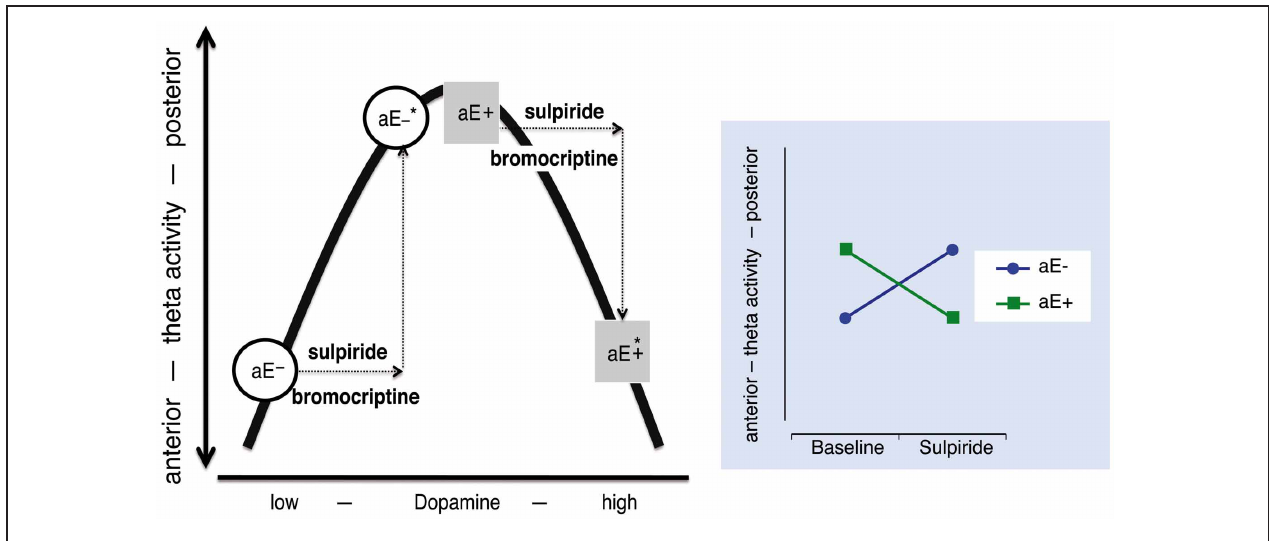
aE − are shifted to positions ( ∗ ) that mark opposing changes (disordinal interaction, see Substance × aE plot on the right side): aE − are shifted to medium and aE + to high dopamine levels, resulting in more or less posterior vs. anterior theta activity, respectively. Such inverse U-shaped functions can be seen as the result of two underlying processes, but without such a specification it is merely a function of